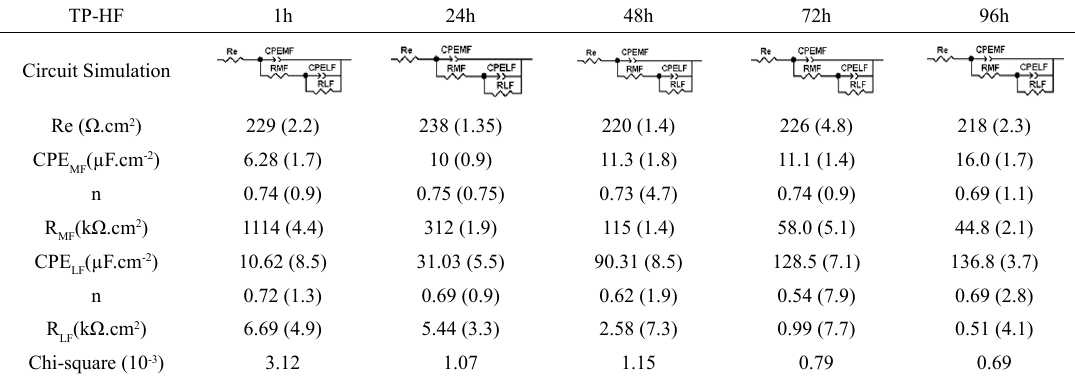
Figure 8. Bode diagrams for tinplate uncoated and tinplate coated with the hybrid films for (a) 24 and (b) 96 hours of immersion in 0.05 M NaCl. Table 4. Equivalent circuits for the TP-HF sample. The error percentage is in